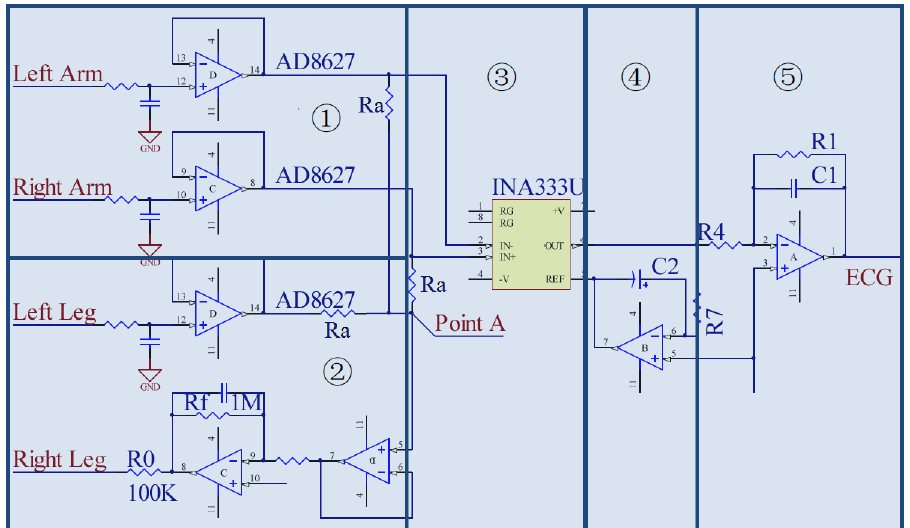
Figure 5. The schematic design of the ECG analog front-end